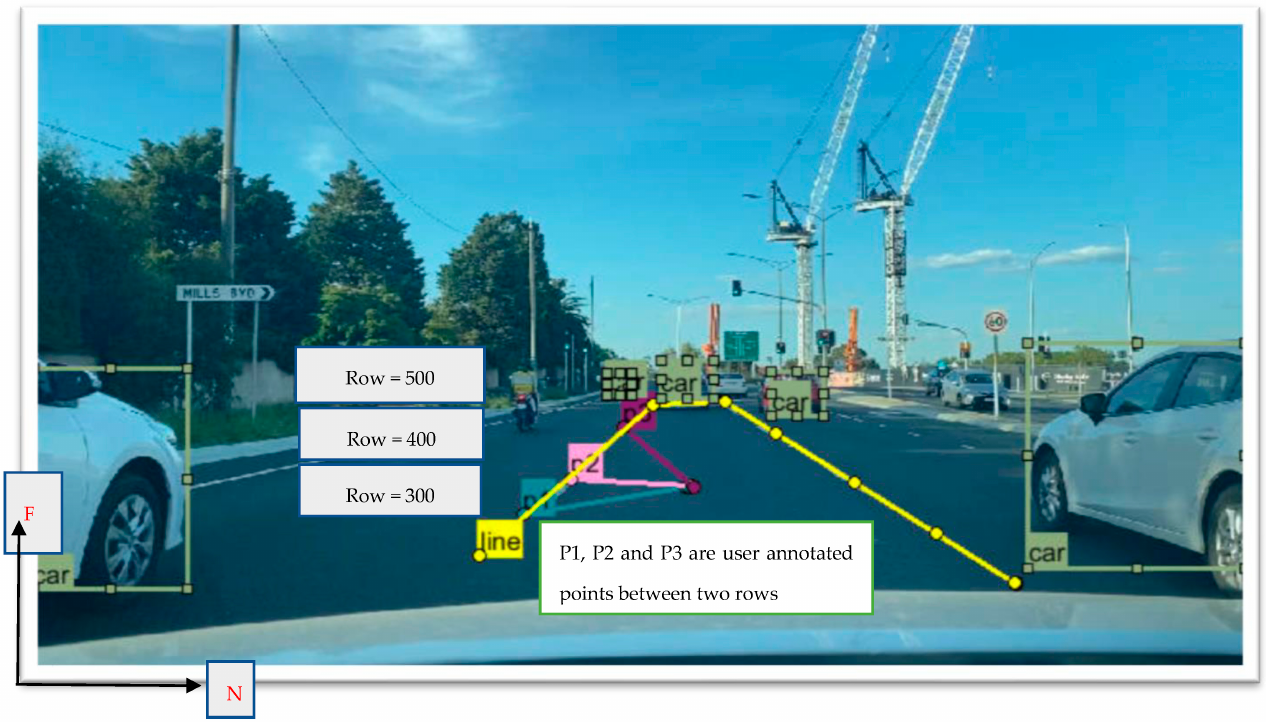
Figure 4. Connecting specified rows via interpolation to generate a smooth curve.